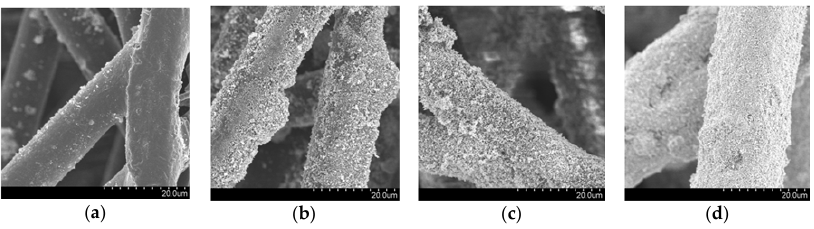
Figure 1. Scanning electron microscopy (SEM) images of ( a ) non-woven fabric fibres before adding the host photocatalyst; ( b ) non-woven fabric with UV-responsible photocatalyst (TiO 2 P 25); ( c ) non-woven fabric with visible-light-responsive photocatalyst (Fe / TiO 2 ); ( d ) non-woven fabric with visible-light-responsive photocatalyst (Cu / WO 3